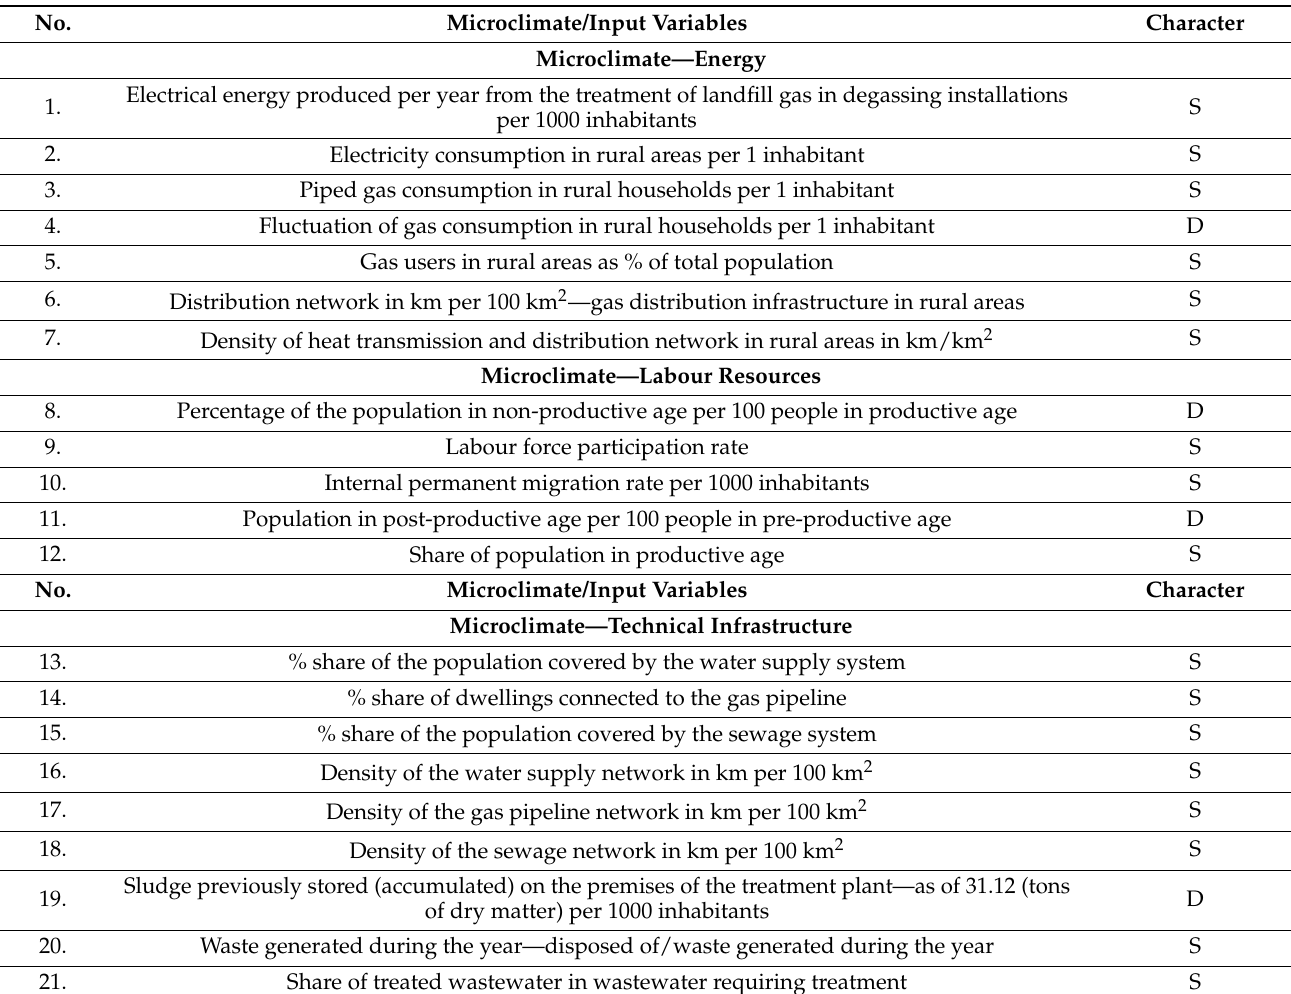
Table 2. Input variables for assessing potential investment attractiveness of Section A businesses on the local level (counties) in Poland in 2019 (PAI A